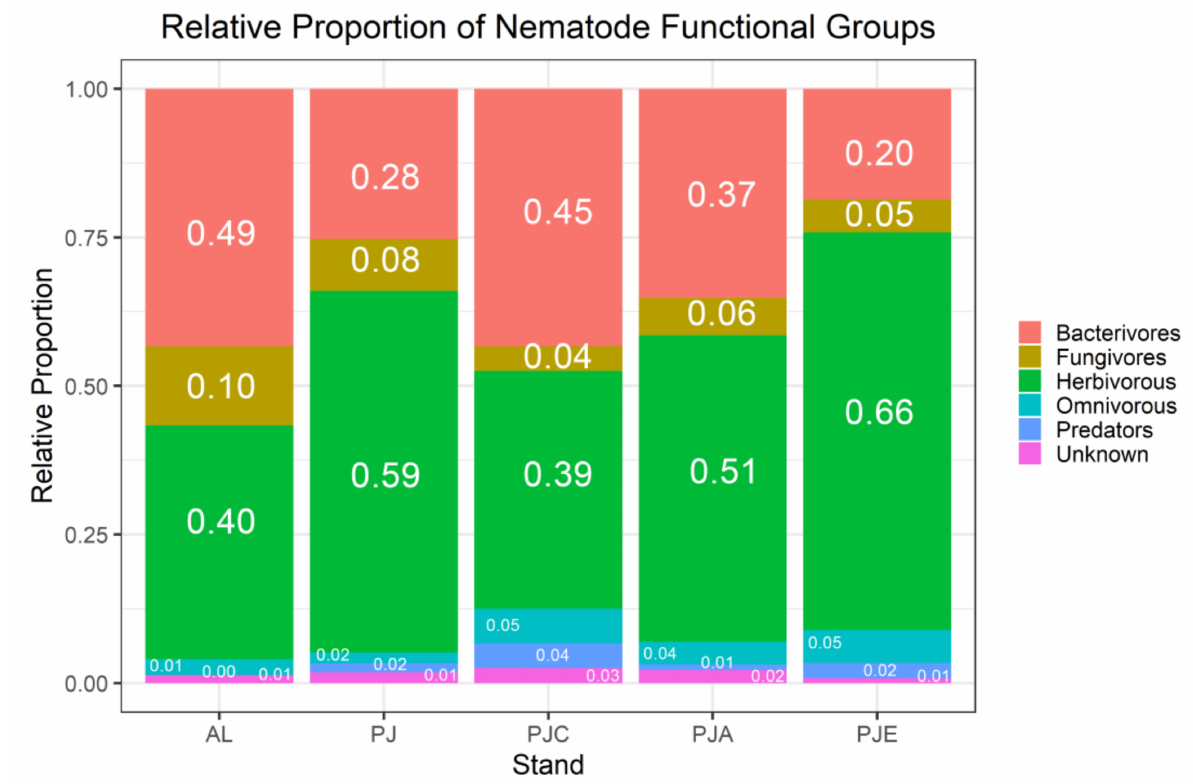
Figure 4. Nematode functional group composition (relative proportion) in the tree stands and agricultural land plots (see Table 1 for site